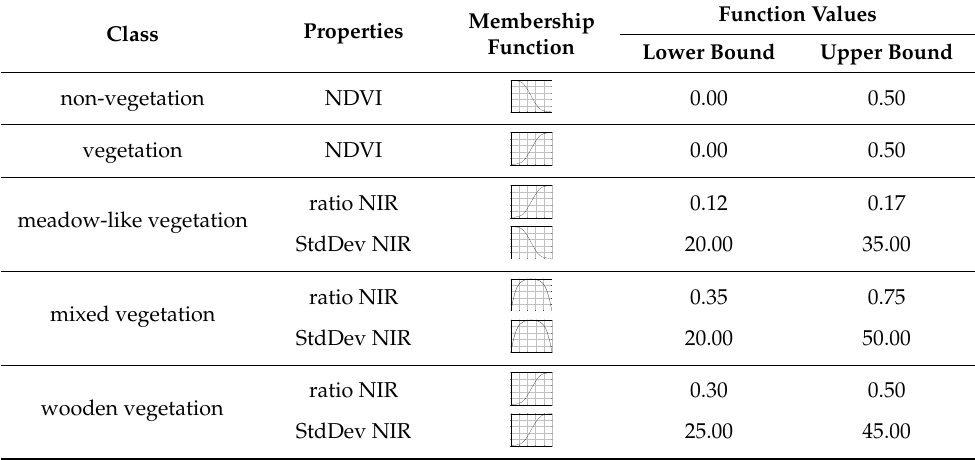
Table 1. Classification scheme with class descriptions for detecting and differentiating urban vegetation.